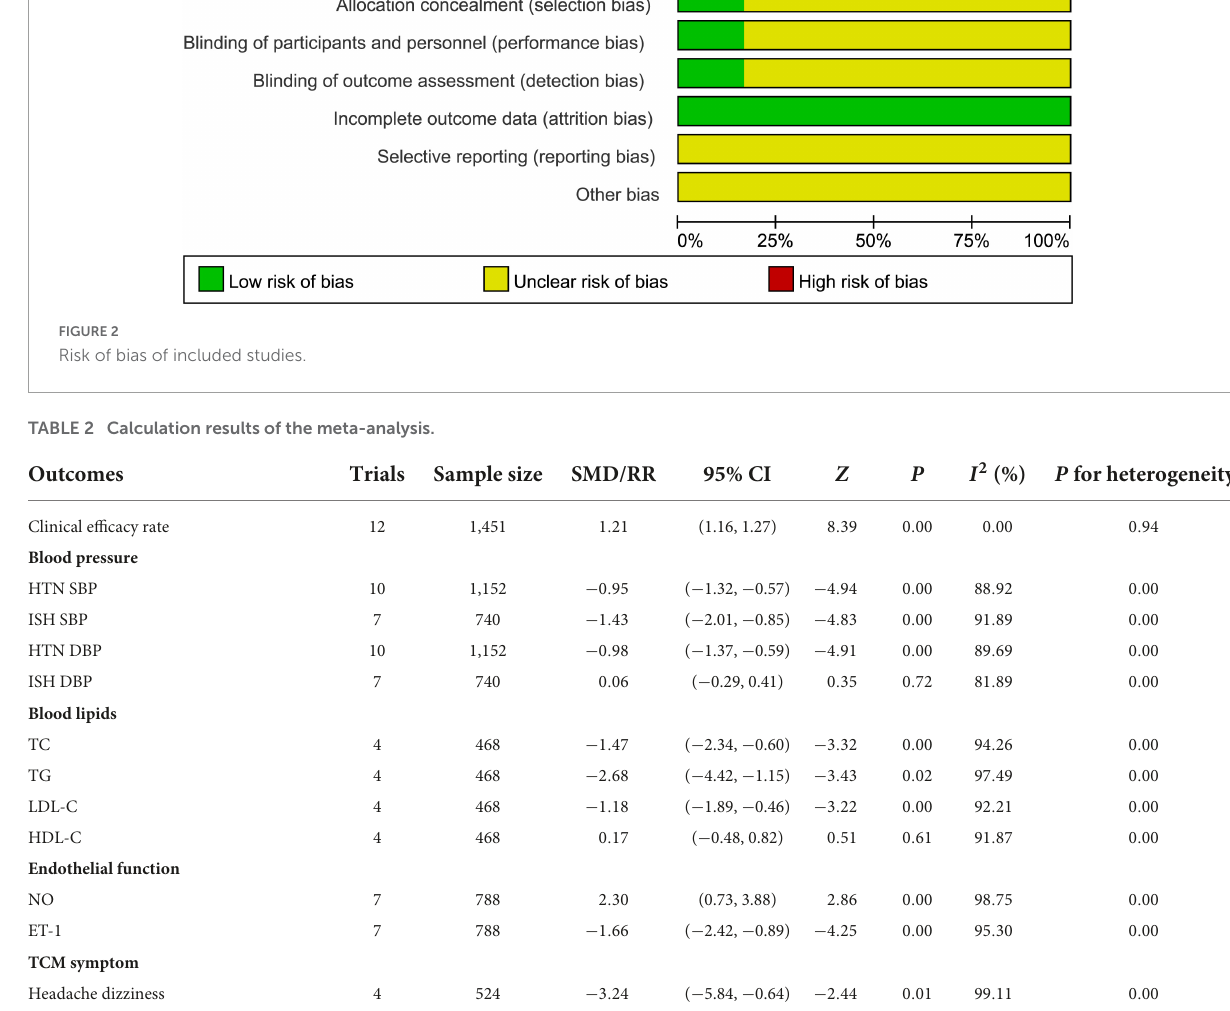
Figure 6B ). Sensitivity analysis suggested that the